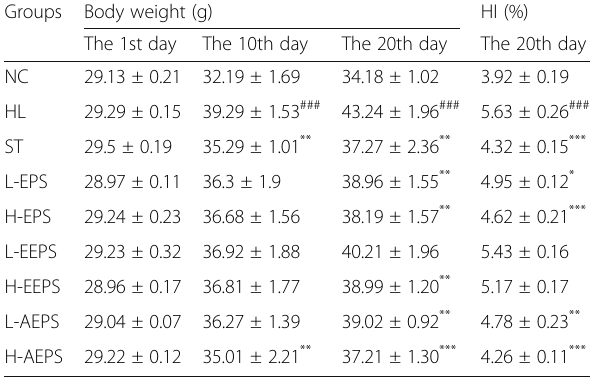
Table 1 Effects of EPS, EEPS and AEPS on body weights and HI of high-fat mice Groups Body weight (g)